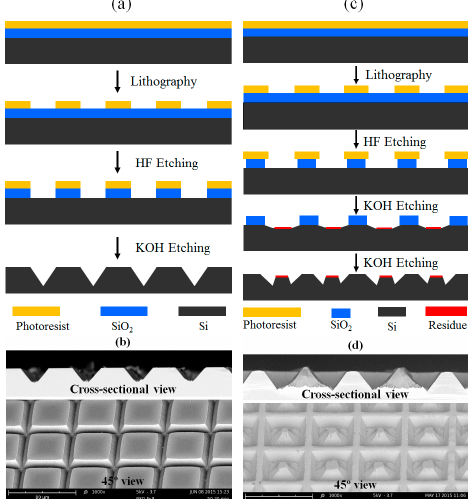
Figure 1. Schematic drawing of the fabrication process without ( a ) or with ( c ) the residue as second masking layer. ( b ) SEM images of cross-sectional view (top) and 45° view (bottom) of the fabricated one-layer micropyramids. ( d ) SEM images of cross-sectional view (top) and 45° view (bottom) of the fabricated two-layer micropyramids surrounded by walls.